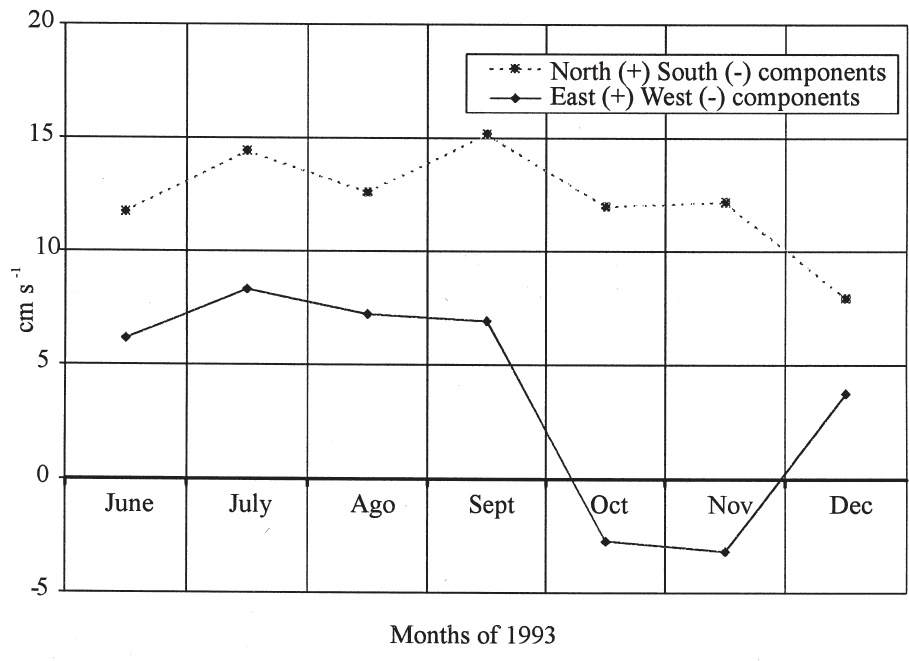
F IG . 5. – Components of currents (monthly averages) along and across the Channel. Small westward components were recorded in the cold